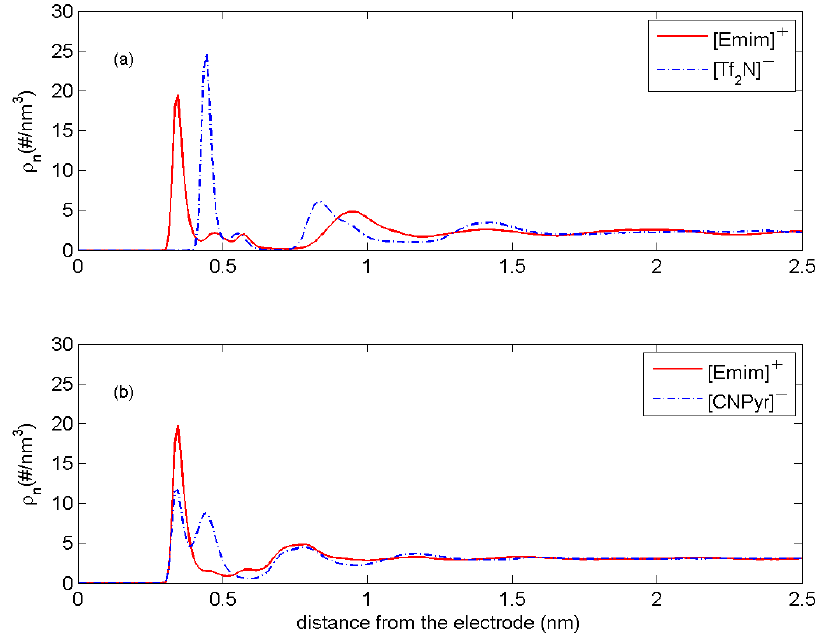
Figure 2. Ion number density profiles of [Emim][Tf 2 N] ( a ) and [Emim][CNPyr] ( b ) near neutral electrodes at 350 K.